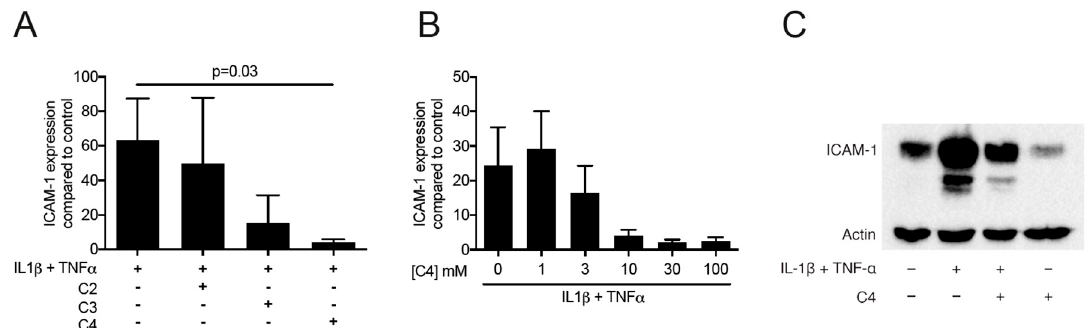
Figure 1. ( A ) Butyrate suppresses the cytokine-induced expression of ICAM-1 in HSC-2 cells. HSC-2 were exposed for 24 h to 10 mM of acetate (C2), propionate (C3) and butyrate (C4), and then stimulated for three hours with 10 ng/mL of IL1 β and TNF α . (+), indicates presence; (-), indicates absence. Data represent the mean change of ICAM-1 expression ± standard deviation. n = 3. Statistical analysis was based on ANOVA test with Tukey`s multiple comparisons correction and significant p - values are indicated. ( B ) Butyrate suppresses the cytokine-induced increase of ICAM-1 in a dose- dependent manner. HSC-2 cells were exposed to different concentrations of butyrate in the presence of IL1 β and TNF α . Data represent the mean change of ICAM-1 expression ± standard deviation. n = 3 ( C ) Butyrate attenuates the IL1 β - and TNF α -induced expression of ICAM-1. HSC-2 cells were exposed to 10 mM of butyrate (C4) in the presence or absence of 10 ng/mL IL1 β and TNF α .